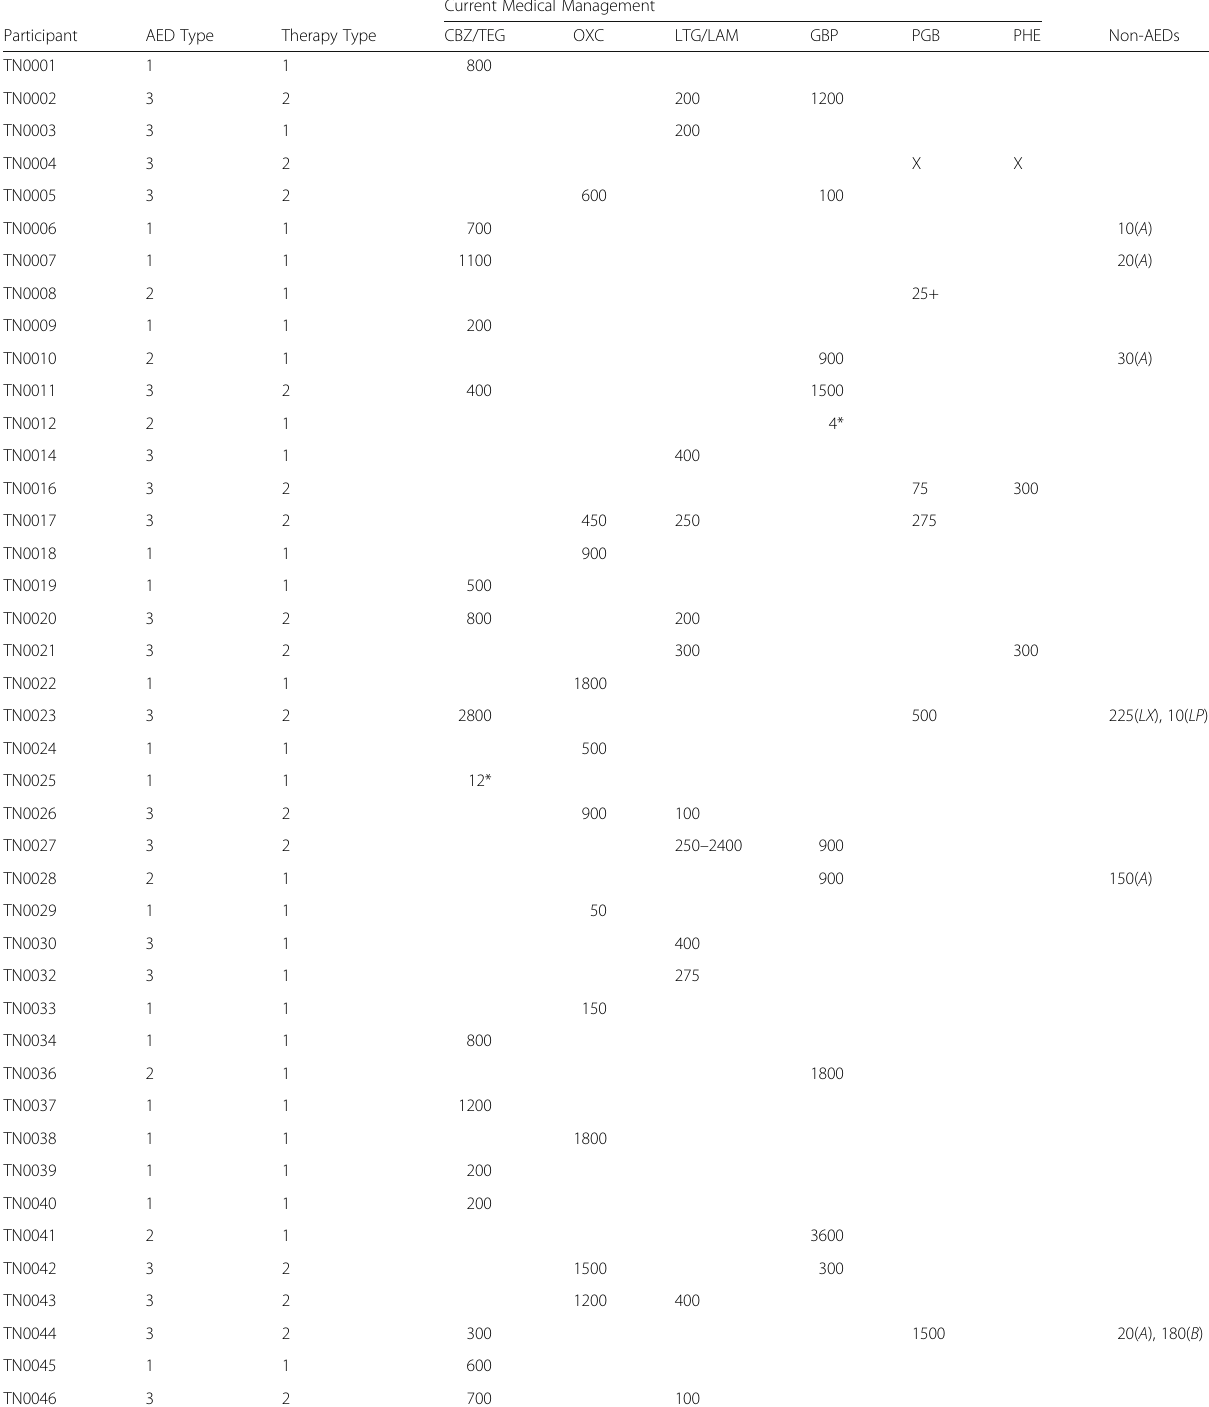
Table 1 Type and dosage (mg) of medication by